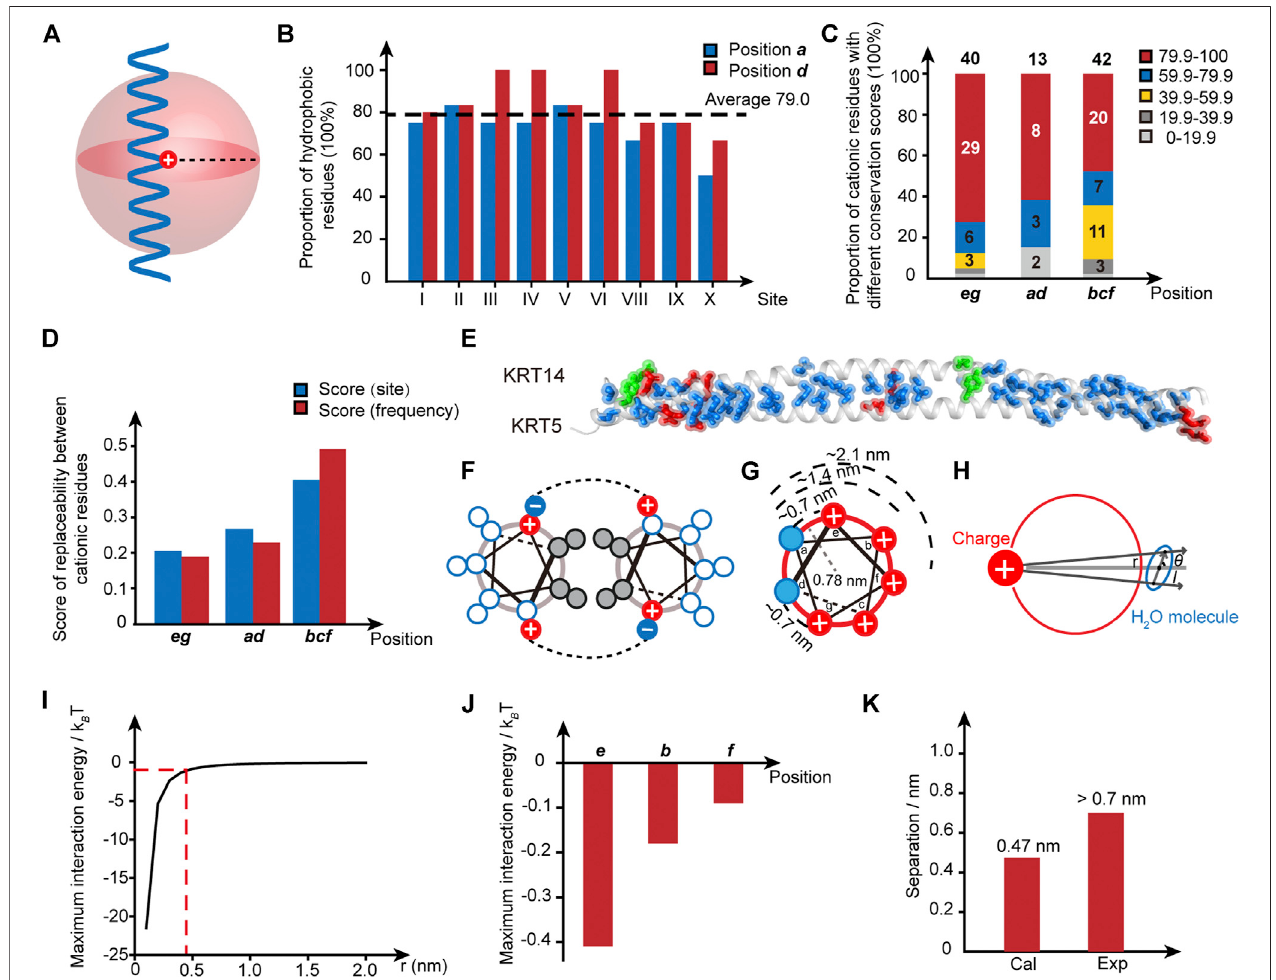
FIGURE 2 | The identity of cationic sides proximal to the hydrophobic domain is conserved. (A) Schematic illustration of the local region surrounding the cationic pathogenic mutation sites ina helical rod domain. (B) The proportion ofhydrophobicresidues for the residues inlanes a and d thatare close to the pathogenic mutation sites.Theaveragescoreisindicatedbythedottedline.Blue,position a ;red,position d . (C) Theconservationscoreofthepositivelychargedresiduesforthepositions eg , ad , and bcf . Different conservation scores are encoded by different colors. The population of samples is indicated by the number in the column. (D) The scores of replaceabilityamongdifferentpositivelychargedresiduesinthewild-typeIFsuperfamily.Blue,thereplaceabilityscorecountedbythenumberofhomologysitesinvolving the substitution among cationic amino acids; red, the replaceability score counted by the occurring frequency of cation-to-cation substitutions. (E) Diagram of the intermolecular interaction pairs formed in a coiled-coil architecture. KRT5-KRT14 coil 2B complex (PDB code: 3TNU) is shown as a representative example. Red, electrostatic interactions; blue, hydrophobic interactions; green, hydrogen bonds. (F) Helix-wheel diagram of a coiled-coil dimer and the intermolecular interactions. Grey, hydrophobic residues; red, positively charged residues; blue, negatively charged residues. (G) Schematic diagram of the distances between the cationic residues and thenonpolarpatch.( H )Schematicillustration ofthecharge-dipoleinteractionbetweenthecationicsidechainandinterfacialwater.Redcircle,thecross-sectionofa helix; solid red disk with a white plus sign, cationic side chain, blue sphere, interfacial water molecules. ( I ) The maximum charge-dipole interaction energy between the cationic side chain and the interfacial water is dependent on the separation between the charged group and the water. The dashed line is indicative of the separation of 0.47 nmwhenthemaximuminteractionenergyisequalto1 k B T .( J )Themaximumcharge-dipoleinteractionenergycalculatedforthechargedgroupsatthesitesof e , b , and f ,respectively.( K )Theseparationwiththecalculatedcharge-dipoleinteractionenergyof1 k B T iscomparedwiththeseparationexistingbetweenthechargedgroup and the interfacial